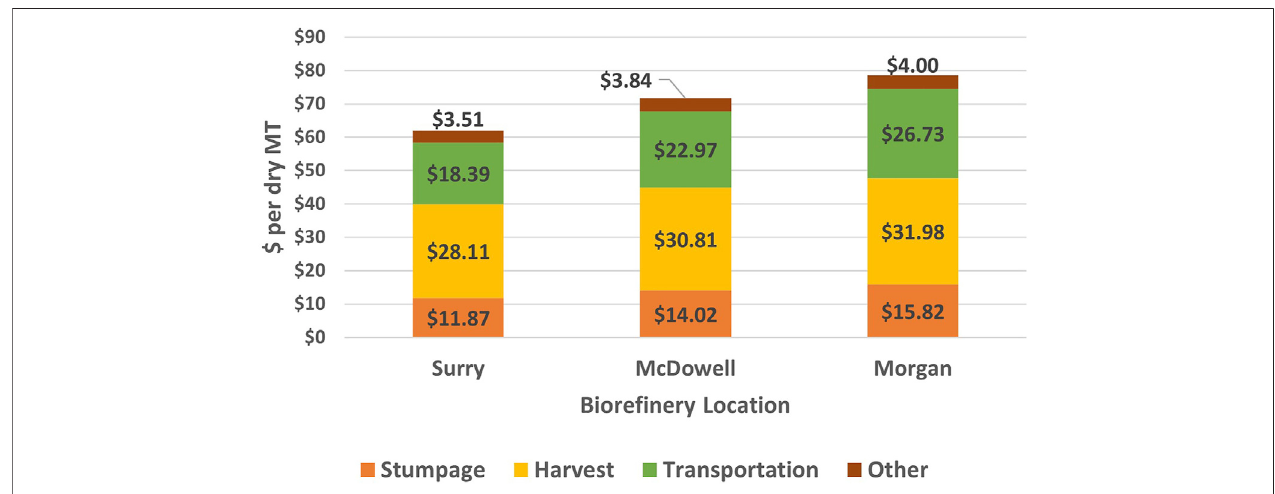
FIGURE 4 | Per dry metric ton costs of delivered feedstocks for each of the biore fi neries.